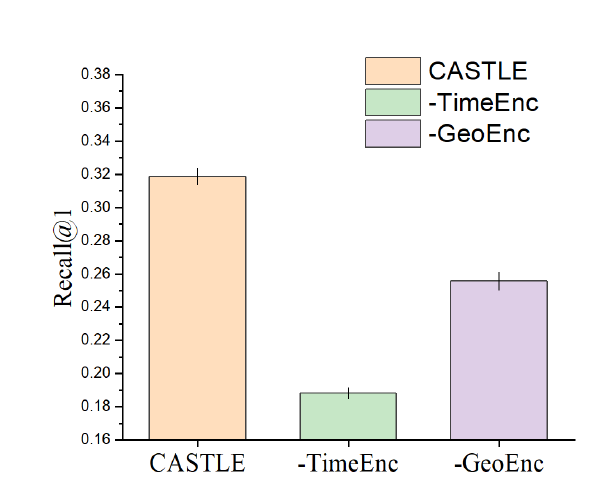
Figure 5. The ablation study results of the CASTLE